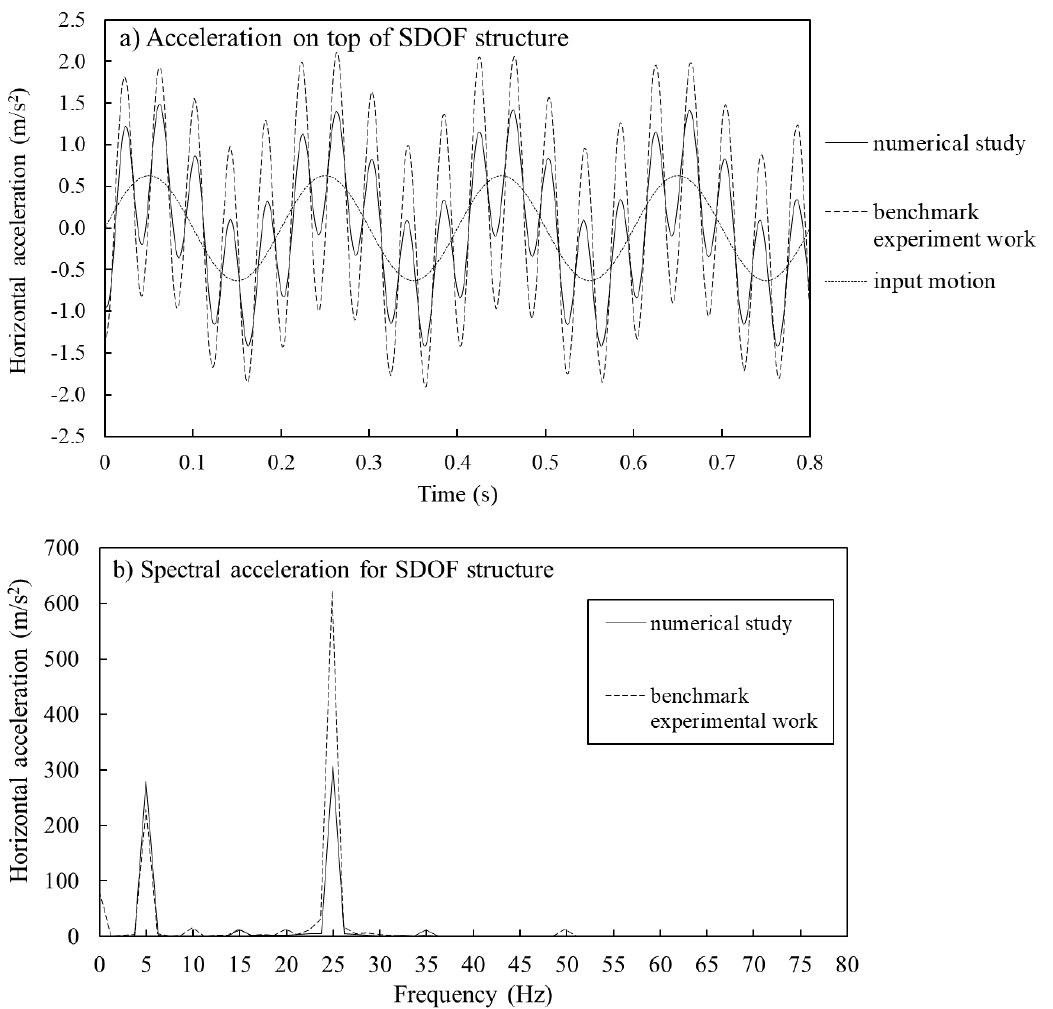
Figure 7: Comparison of the computations and the experimental measurements (Durante, 2015) obtained at the top of the structure in the steady-state response: a) horizontal accelerations, b) evaluation of the spectral response of the computed and measured horizontal